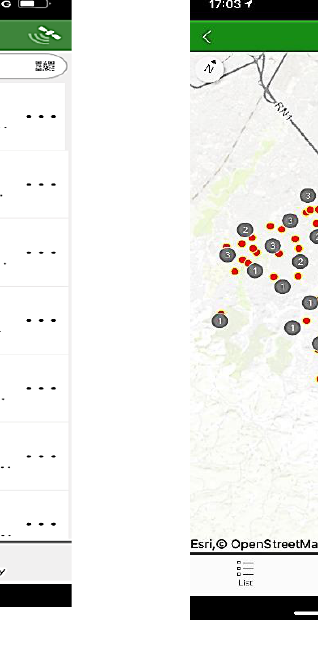
Figure 25. User Interface (Source: Authors).